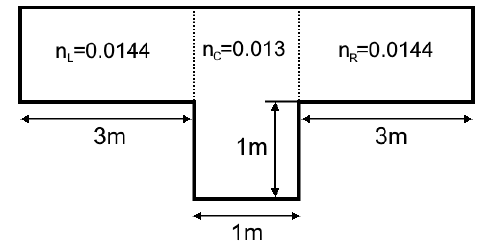
Figure 10 . Two stage rectangular compound section